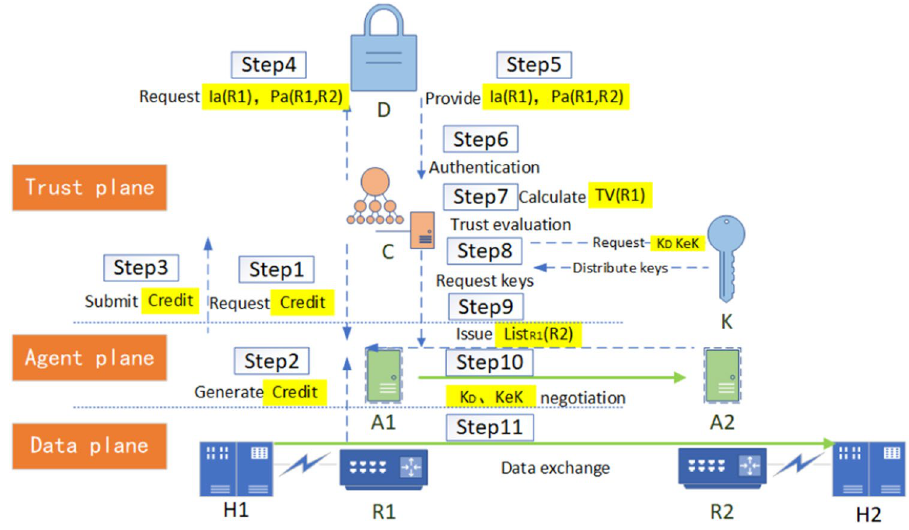
Figure 6. Data exchange process in the mode for the controller to issue Segment